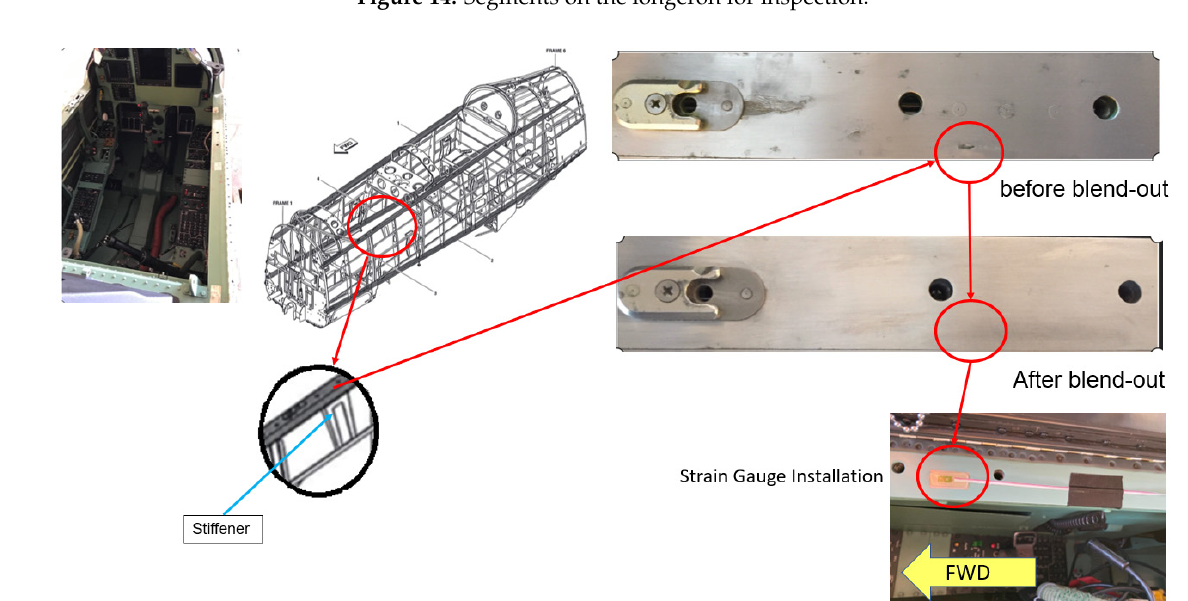
Figure 15. Blend out of corrosion and strain gauge installation.